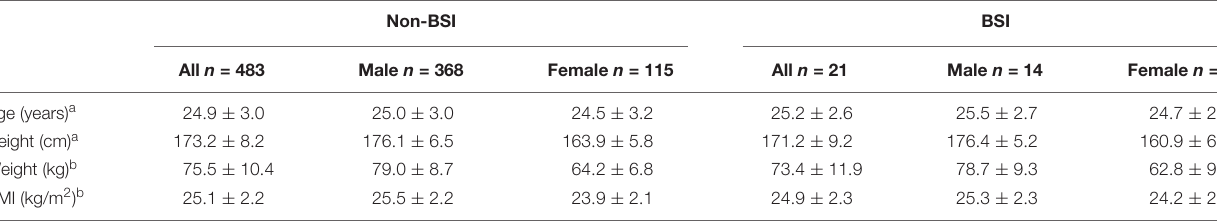
TABLE 1 | Baseline demographics of Marine Corps officer candidates.